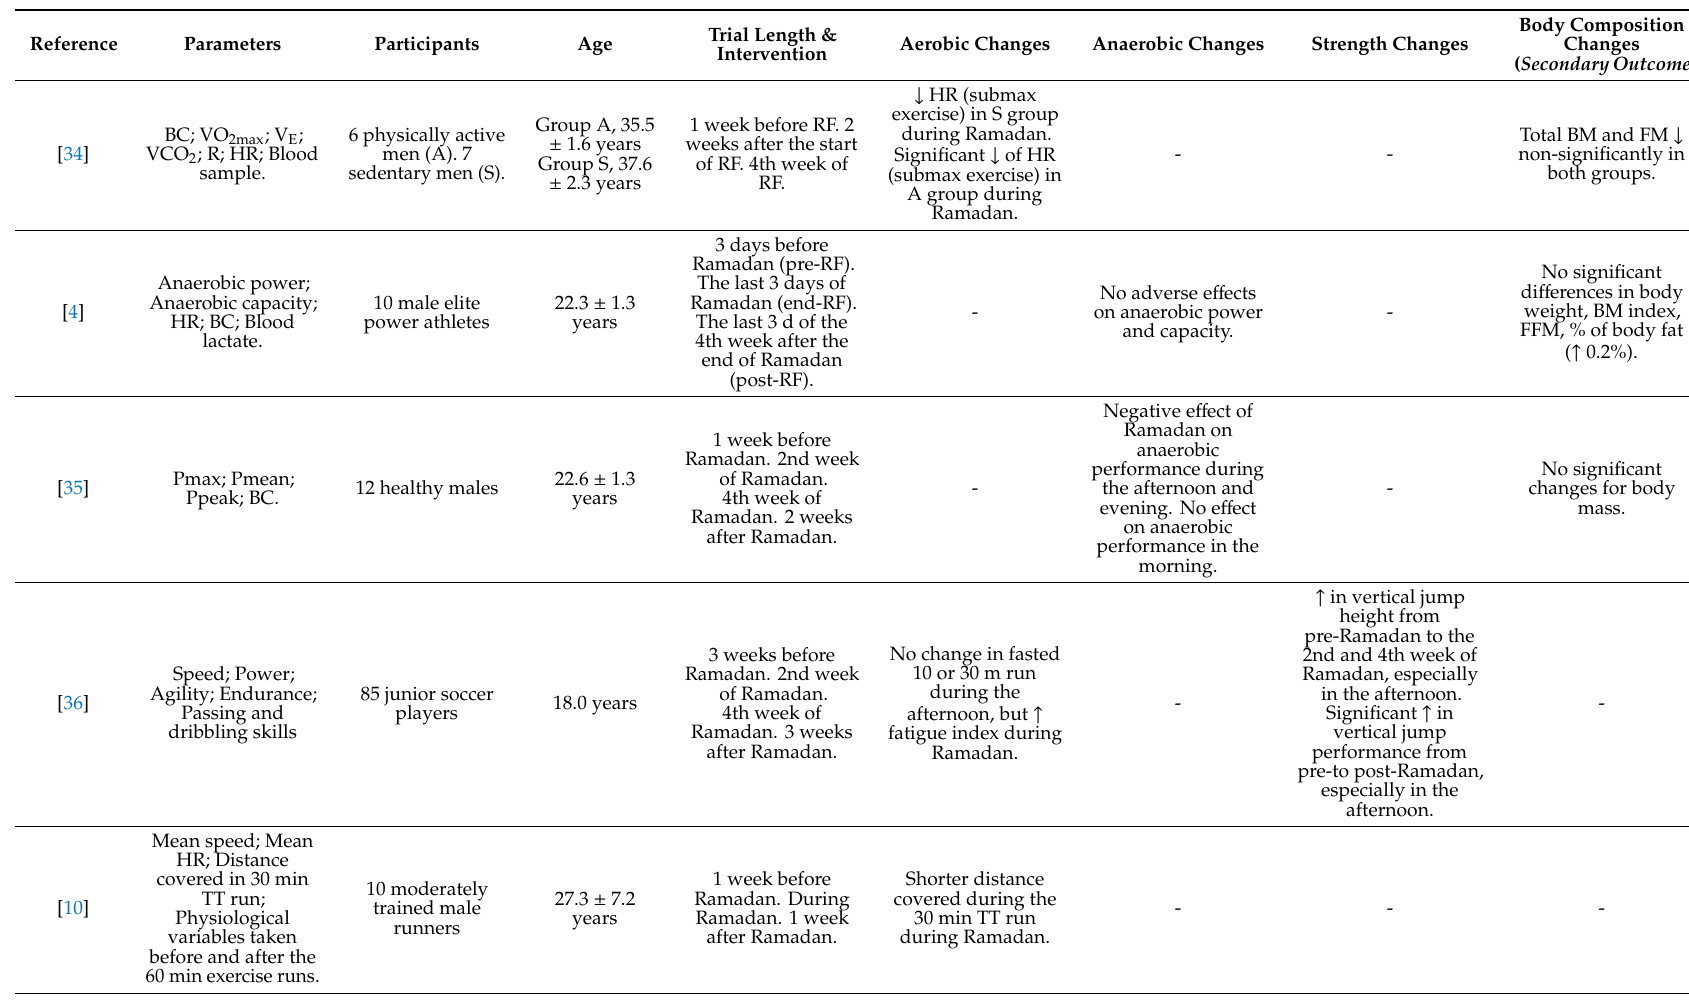
Table 1. Summary of studies evaluating the e ff ects of intermittent fasting on physical performance and body